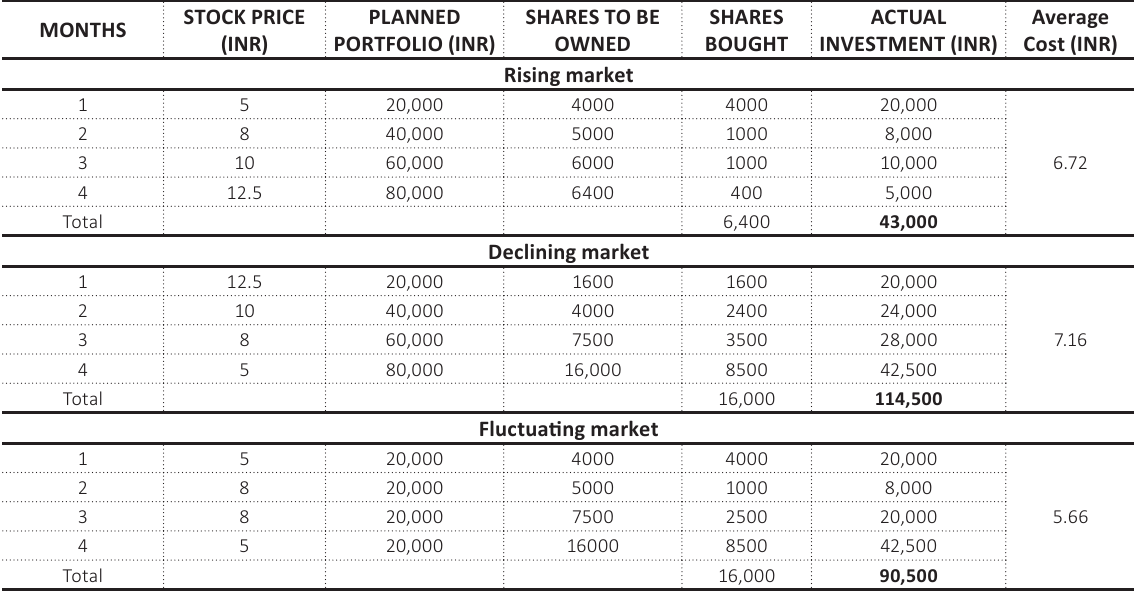
Table A2. Illustration of the Value Averaging Strategy – similar market scenarios under the VA strategy, wherein the investor seeks a monthly increase of INR 20,000 in the portfolio